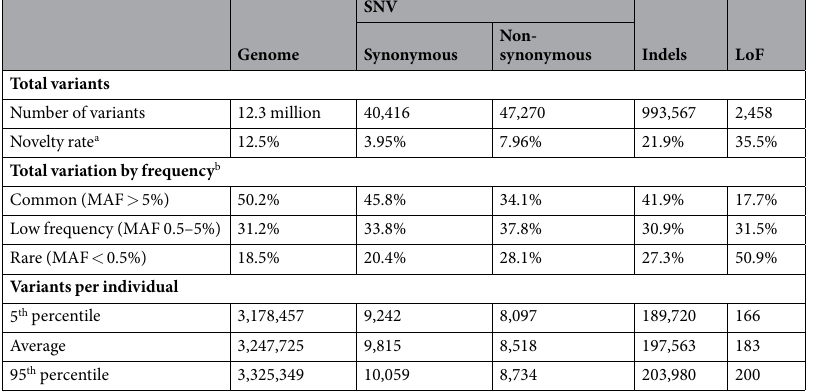
Table 1. Discovered autosomal variants. a Versus Kaviar, dbSNP 144, and ExAC. b Allele frequencies estimated in